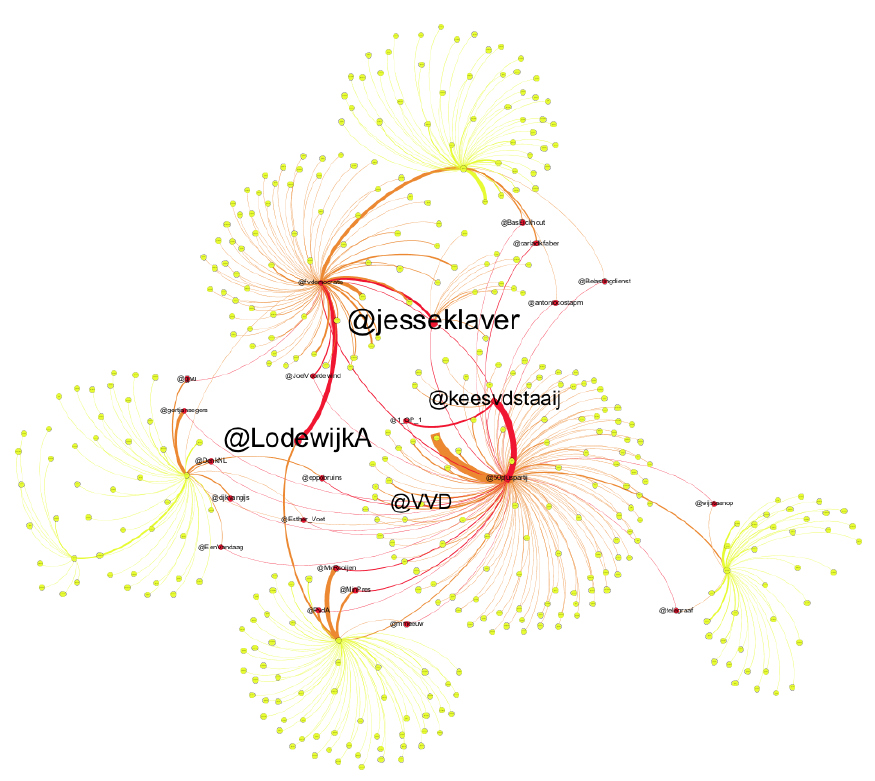
Figure 3. Twitter network, Dutch